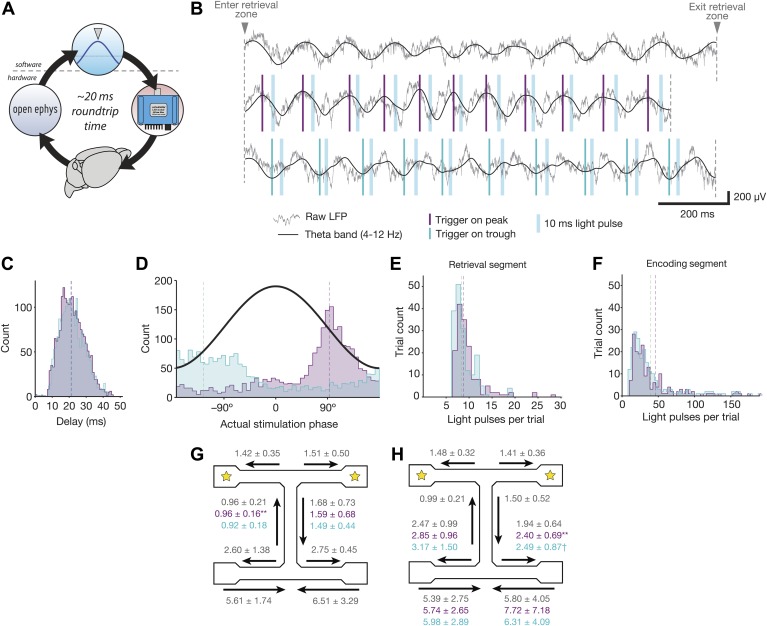
Properties of theta-triggered stimulation.(A) Schematic of steps involved in delivering closed-loop
feedback. An event occurs in the brain (bottom), which is detected and
digitized by the Open Ephys recording hardware (left), and sent to software
for analysis (top). When the target event is detected, the software
activates an LED (right) which delivers light to brain via implanted fiber
optic cables (bottom). (B) Examples of raw and theta-bandpassed
LFP during baseline trials (top), peak-triggered stimulation trials
(middle), and trough-triggered stimulation trials (bottom). Vertical blue
bars indicate the time at which 10 ms light pulses occur on each cycle.
(C) Distribution of delays between detection of the actual
theta peak (purple) or trough (teal) and the time of stimulus delivery.
(D) Distribution of actual theta phases at which stimulation
occurred, for both peak (purple) and trough (teal) trials. Peak-triggered
stimulation tends to occur during the falling phase of theta, whereas
trough-triggered stimulation occurs around the actual trough and rising
phase. Phase was calculated for data filtered offline between 4 and 12 Hz,
to eliminate the phase delays inherent in online filtering. (E)
Distribution of pulses per trial for the retrieval segment of the track.
(F) Same as E, but for encoding segments of the
track. (G) Occupancy times in different segments of the track
for trials with retrieval-segment stimulation. Values for peak-triggered and
trough-triggered stimulation are shown in purple and teal, respectively
(mean ± SD for N = 4 mice; ** =
occupancy time decreased significantly for one mouse, p<0.005, Wilcoxon
rank sum test with Bonferroni correction). (H) Occupancy times
in different segments of the track for trials with encoding-segment
stimulation. Values for peak and trough-triggered stimulation are shown in
purple and teal, respectively (mean ± SD for N =
4 mice; ** = occupancy time decreased significantly for one
mouse, p<0.005; † = occupancy time increased significantly
for one mouse, and decreased significantly for a different mouse,
p<0.05; Wilcoxon rank sum test with Bonferroni correction).